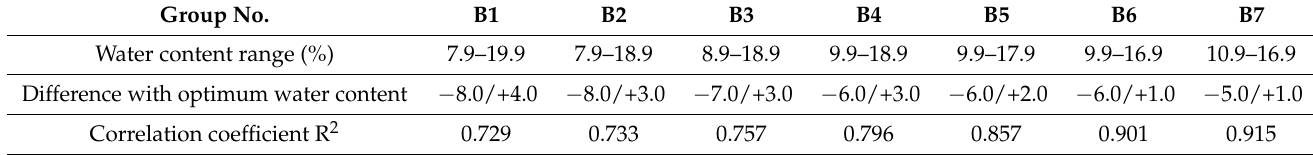
Table 5. Correlation coefficients of calibration equations for soil sample groups with different water contents. Group No.